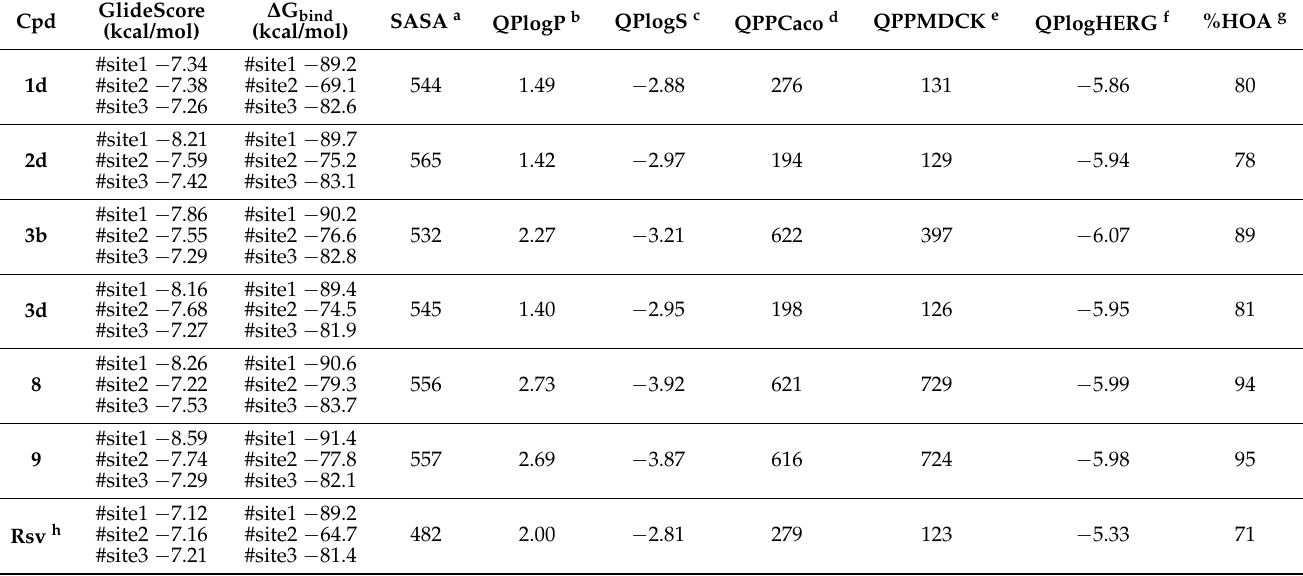
Table 2. Top-ranked hits and their parameters obtained from in silico